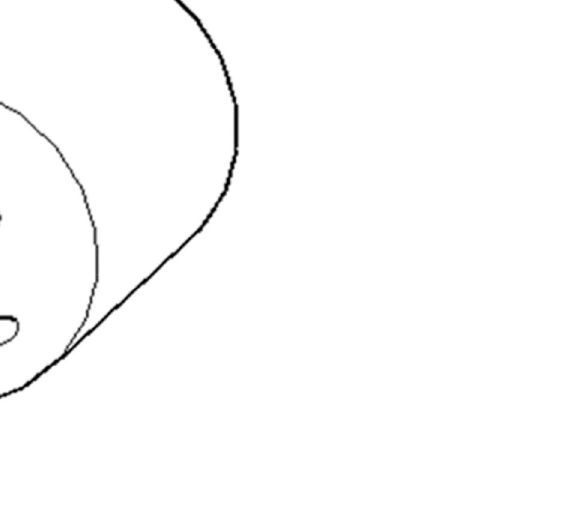
Figure 6. 7-hole probe calibration coordinate